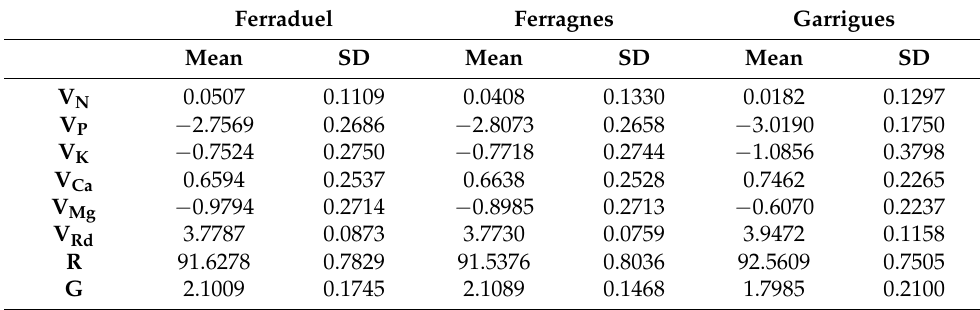
Table 6. CND standards (average and standard deviation) of the multinutrient variables obtained from the nutrient content in each of the almond